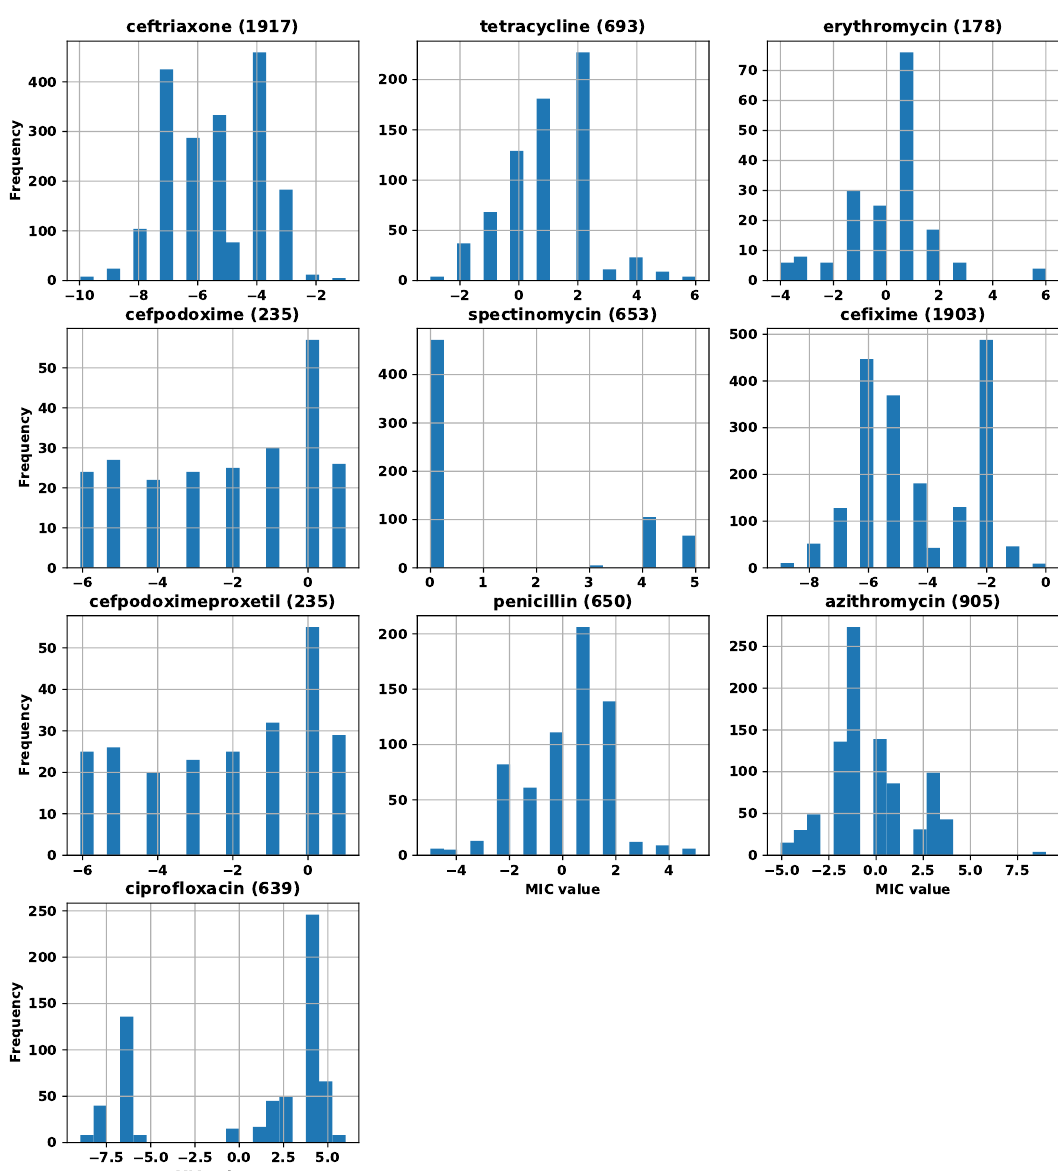
Figure A2. Distribution of N. gonorrhoeae MIC values for different antibiotics. These are the values after processing and conversion to log 2 scale. The antibiotic’s name is printed on the title of each sub-figure. The number of genomes is presented in